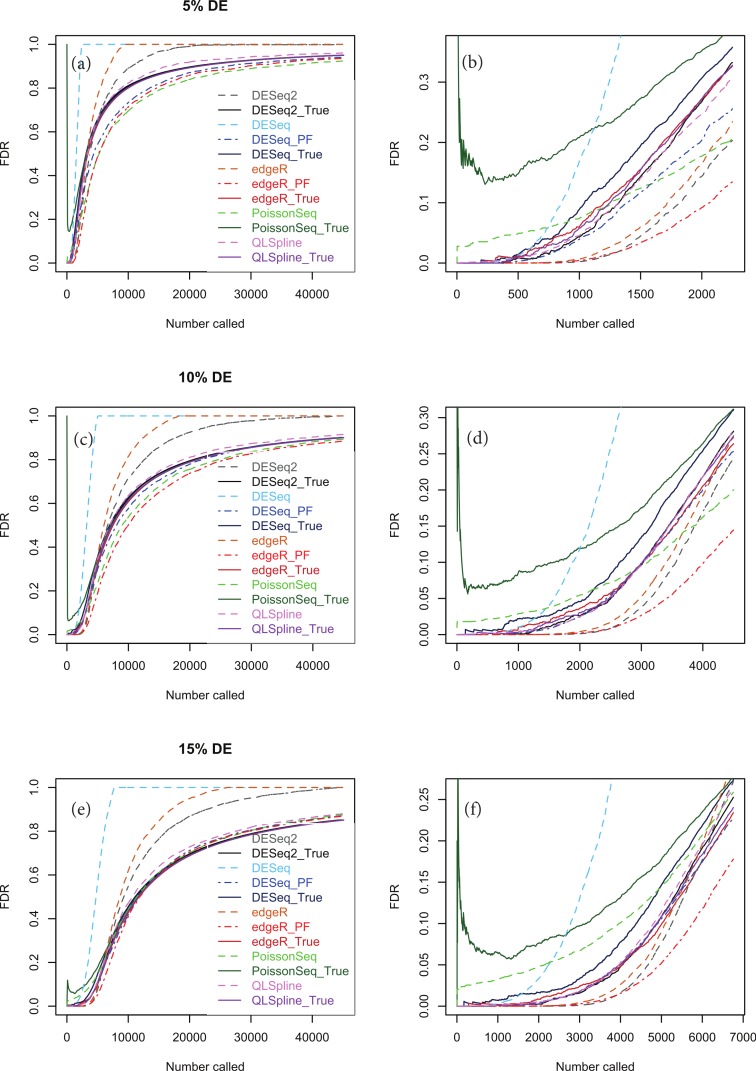
True (solid curves) and estimated (broken curves) FDRs for n = 4 replicates of synthetic negative binomial data in each of two conditions with 5, 10 and 15% genes DE in the second conditon.Plots (B), (D) and (F) are expanded views of the plots (A), (C) and (E) respectively covering a subset of genes up to a significance point roughly corresponding to the number of DE genes.